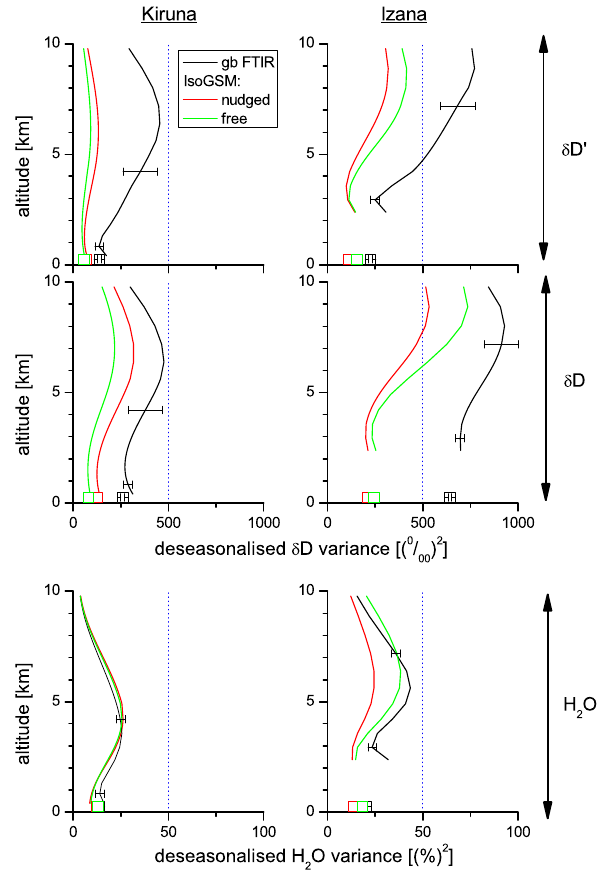
Fig. 10. Profiles of the variance of the deseasonalised daily mean data. Left panels for Kiruna and right panels for Iza˜na. The pan- els from the bottom to the top present data for H 2 O, δ D, and δ D 0 . The black, red, and green lines represent the FTIR measurement, nudged model run data, and free model run data, respectively. The error bars represent the estimated error variance for the lower and middle/upper troposphere. The open squares and error bars upon the bottom x-axis represent the variances for the column integrated